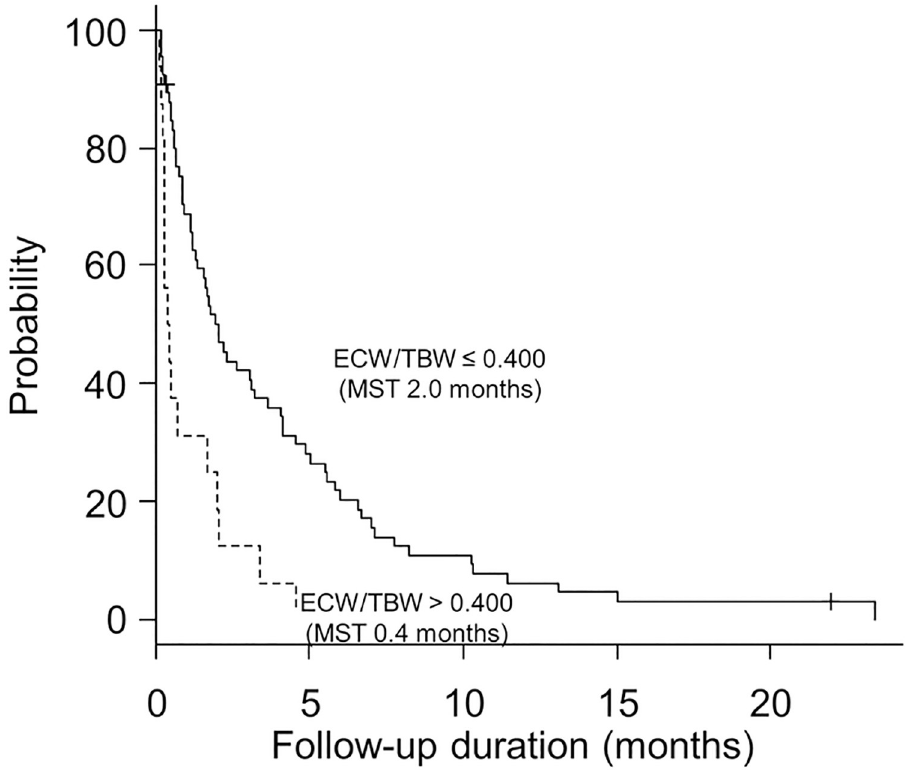
Fig 7. Association of extracellular water to total body water ratio with the duration of first dose reduction or drug withdrawal. The cutoff for extracellular water to total body water ratio (ECW/TBW) was 0.400, as previously reported. Patients with an ECW/TBW of > 0.400 experienced significantly shorter duration of first dose reduction or drug withdrawal than those with an ECW/TBW of � 0.400 (0.4 months vs 2.0 months, P < 0.001).